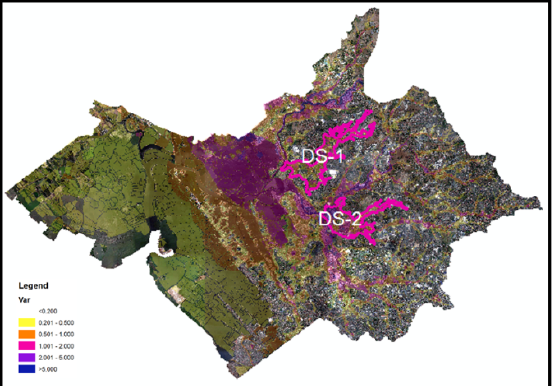
Figure 14. Locations of Depression Storages